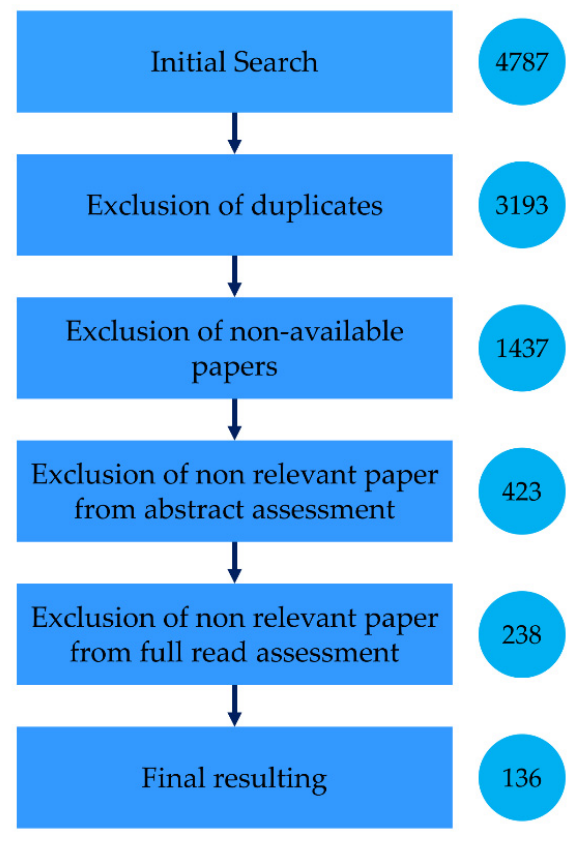
Figure 4. Screening mechanism of Paper selection.